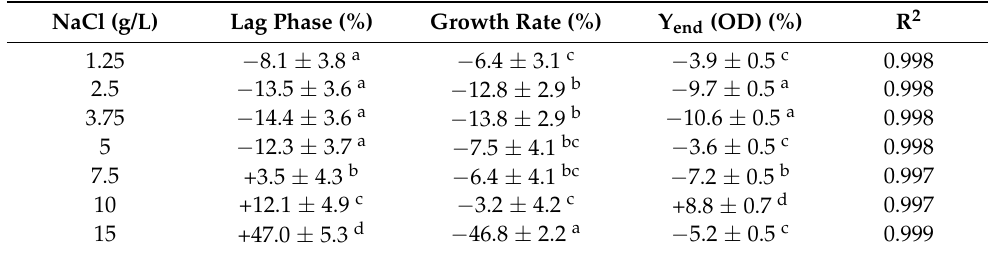
Table 3. Variations (%) in lag phase duration, growth rate and final OD reached (Y end ) of Z. mobilis UMB479 grown in liquid culture in presence of NaCl (1.25–15 g/L) respect to control culture (no NaCl). Mean and standard deviation of two replicates; different superscript letters within a column indicate significantly different samples ( p < 0.05). NaCl (g/L) Lag Phase